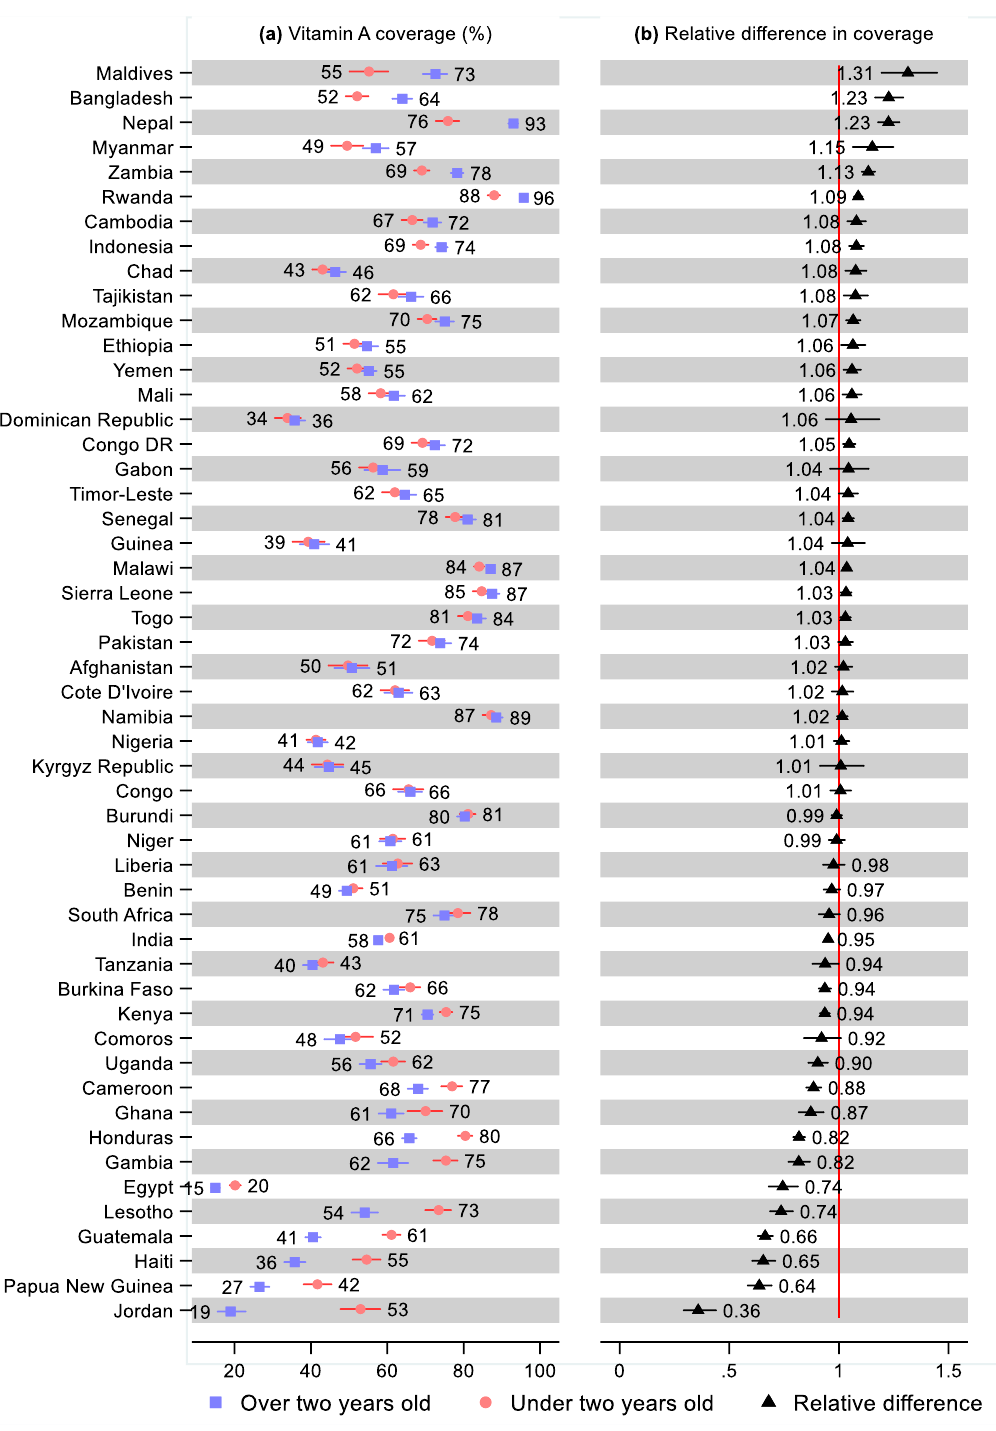
Figure 10. Percentage of children under two years old (6–23 months) and over two years old (24–59 months) that received vitamin A supplementation by country. Notes: 95% confidence intervals are shown. Countries are ordered from largest to smallest relative age difference. Some confidence intervals may be narrower than the symbol for the estimate and are therefore not visible. See Table S17 in the Supplement for the tabulated estimates and confidence intervals. See Tables S18–S20 and Figures S28–S30 in the Supplement for the differences by sex, living standards, and urban–rural